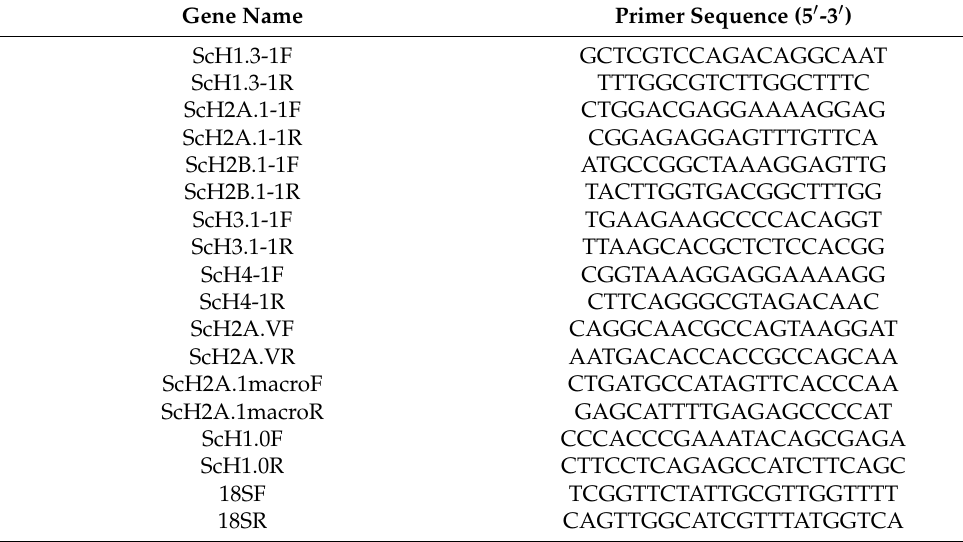
Table 1. Histone primers of S. constricta for